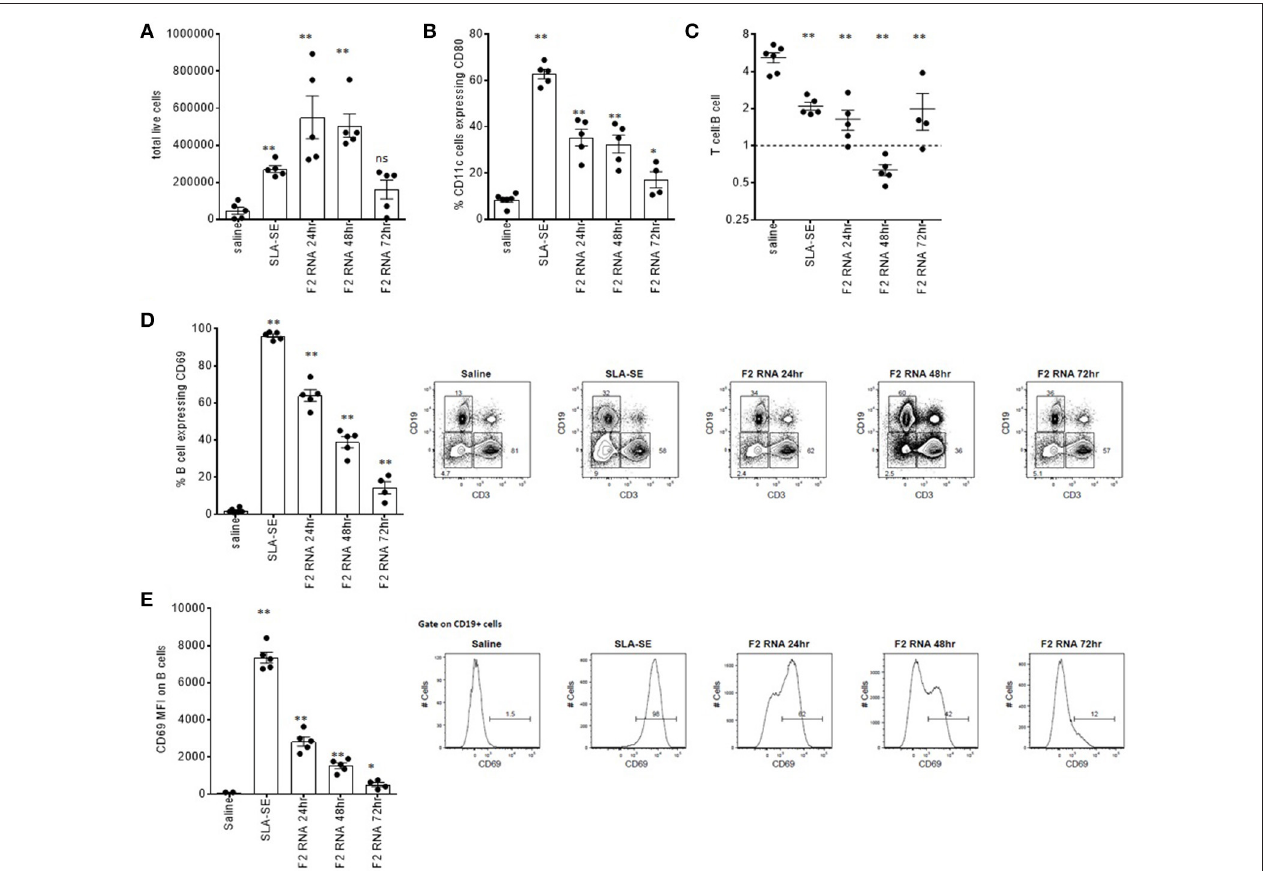
FIGURE 2 | Rapid local immune activation following inoculation of RNA-F2. C57BL/6 mice were injected with 20 µ l vaccine into calf muscle. The RNA vaccine was prepared to provide a total of 10 µ g dose. SLA-SE was injected at 5 µ g per injection to serve as a positive control for immune activation. At various times after injection, the draining lymph node was excised and single cell suspensions prepared and (A) enumerated. Cells were incubated with fluorescently labeled antibodies then subjected to flow cytometry to determine (B) activation state (CD80 expression) on CD11c-expressing cells; (C) T cell (CD3) to B cell (CD19) ratio; (D,E) activation state (CD69 expression) on CD19-expressing B cells. Each point depicts the data from a single sample ( n = 5 per group), while the horizontal and vertical bars show the mean and SEM, respectively. Data are representative of results obtained in 2–3 independent experiments. ns = not significant, and * and ** = p -value < 0.05 and < 0.01, respectively, when comparing the indicated group against the saline injected control group.